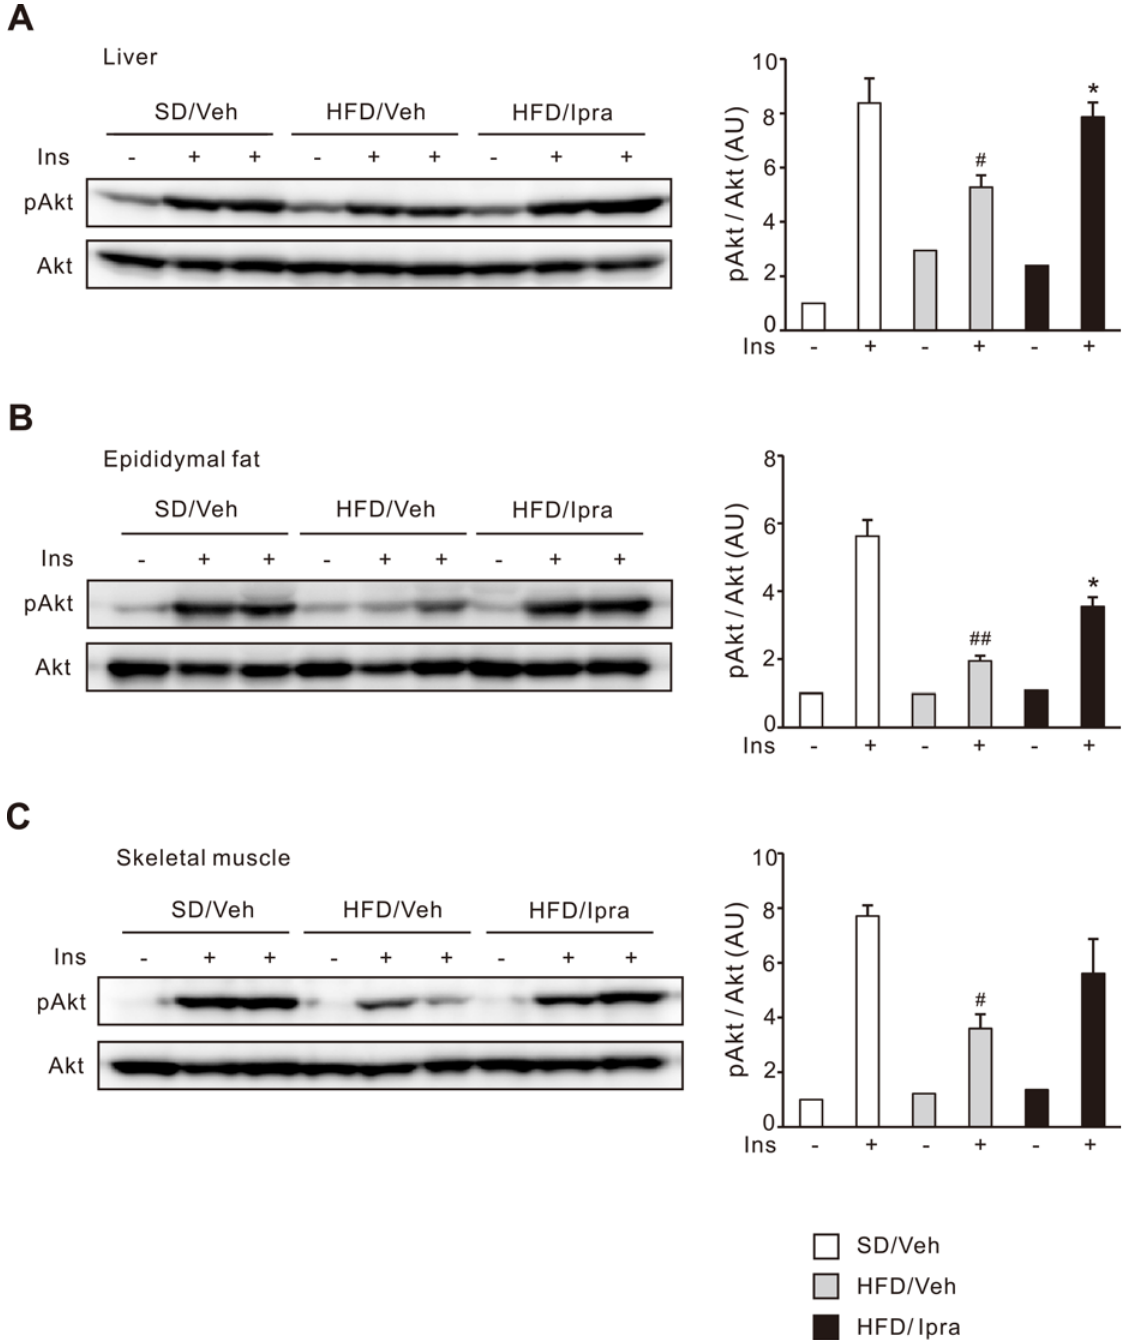
Fig 4. Effect of ipragliflozin on insulin signaling in HFD-fed WT mice. Representative immunoblots and quantification of phosphorylated Akt (S473) in the (A) liver, (B) epididymal fat, and (C) skeletal muscle after 4 weeks of the vehicle or ipragliflozin treatment. After 16 h of fasting, mice were injected with insulin (5U/kg) or phosphate buffered saline to portal vein, and the liver was collected 3 minutes later. Ins, insulin. # p < 0.05, ## p < 0.01 vs SD/Veh; * p < 0.05 vs HFD/Veh. n = 2 – 6.